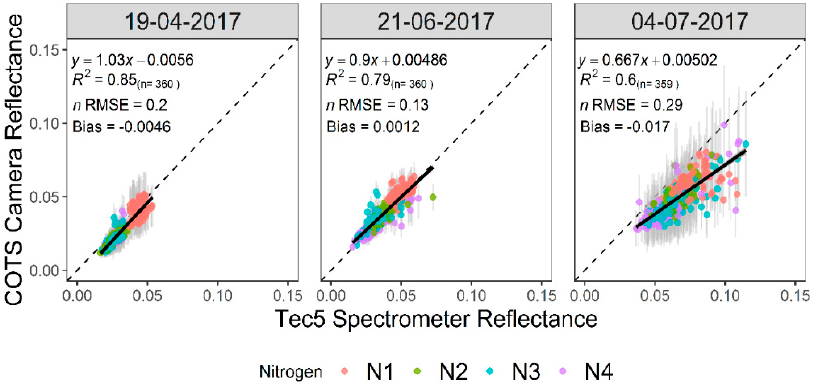
Figure 11. Accuracy assessments of blue band reflectance for three dates. Tec5 reflectance is convolved to the spectral response of the COTS cameras for comparison. The points are coloured based on nitrogen treatment applied to the plot. Standard deviation of reflectance measured by the COTS cameras is presented by vertical error bars. The dashed line represents the 1:1 line.